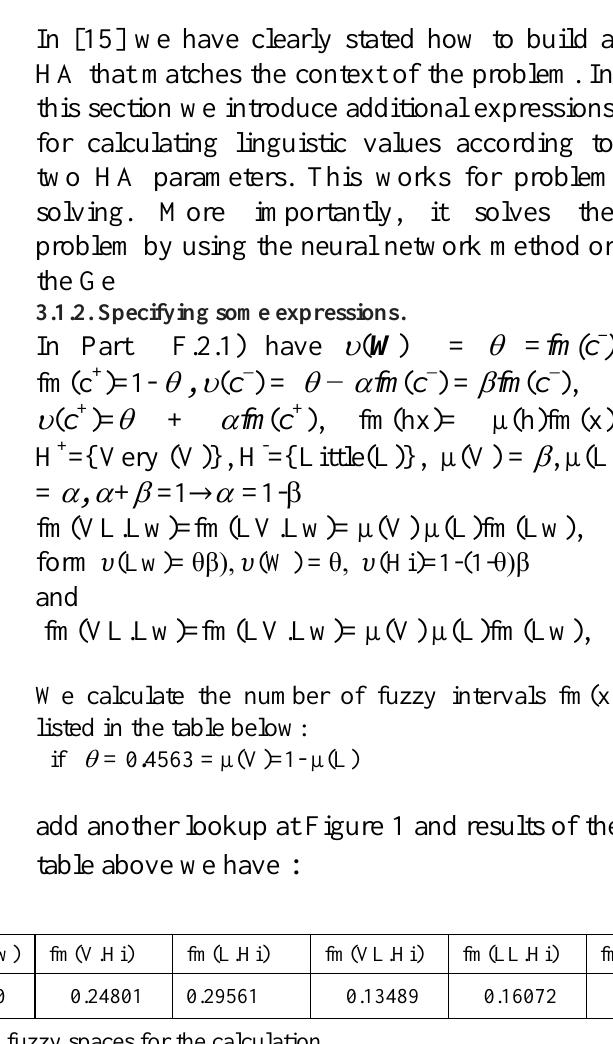
Table 1. The value of the fuzzy spaces for the “There is an induced about the trend change in the forecasting in the discourse space into the space of [0,1] where there is a trend change to the quantitative semantics value due to the impact on the terms of the hedges. That is the basic to we construct the mathematics model for forecasting time series by (HA) approach” [15]. We want to say about µ(h), the single operator impact on the operand (language